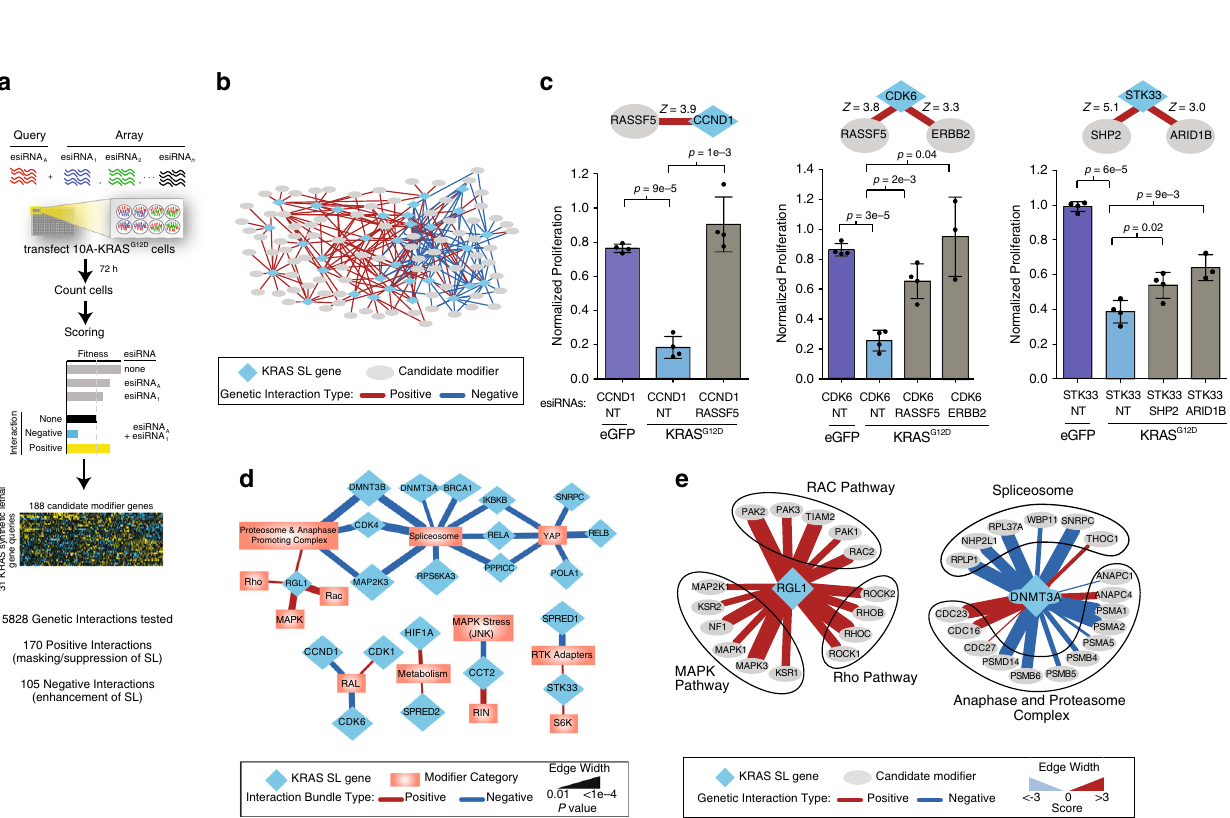
Fig. 3 An isogenic cell line screen validates KRAS synthetic lethal network genes. a MCF10A cells stably expressing eGFP or a mutant KRAS construct were reverse transfected with esiRNAs targeting speci fi c genes. After 72 h, relative proliferation was compared between eGFP and KRAS mutant cells to score genetic interactions. b Proliferation of uniformly plated MCF10A cells expressing eGFP, KRAS G12V or G12D grown in the presence or absence of 20 ng/ml EGF for 72 h. n = 4 biologically independent samples. c Immunoblot of isogenic cells grown in the presence or absence of 20 ng/ml EGF for 24 h. Experiment was repeated twice with similar results. d Proliferation of eGFP or KRAS G12D cells grown in the indicated media conditions after non-targeting (NT) or KRAS knockdown for 72 h, normalized to NT control. n = 4 biologically independent samples. e Volcano plot re fl ecting the magnitude of change in proliferation after gene knockdown in KRAS G12D cells grown in minimal media compared to eGFP expressing control grown in full media versus the signi fi cance of this effect calculated among replicates. Dotted lines represent the indicated false discovery rate (FDR) cutoffs. KRAS indicated as control (red). f Relative proliferation of gene knockdown in eGFP or KRAS G12D cells compared to non-targeting control. Genes selected based on genetic interactions with <1% FDR. n = 4 biologically independent samples. g Signed genetic interaction scores for genes in the broader RAS pathway grouped into functional categories. The most negative scoring genes in each category are listed. h Signed genetic interaction score of retested literature curated KRAS synthetic lethal genes and their source. A subset of genes from Luo et al. 40 are indicated for clarity. i Comparison of genetic interaction scores for genes involved in the RAS or MAPK pathway (RAS/MAPK), RTK signaling, KRAS synthetic lethal genes from the literature (green), or predicted synthetic lethal network genes (purple). p values based on comparison against a median interaction score of zero (bottom) and between groups (above), both by two- tailed Student ’ s t test. Boxes represent the median, hinges span 25 – 75th percentile and whiskers span 10 – 90th percentile. Data are presented as mean values ± s.d.